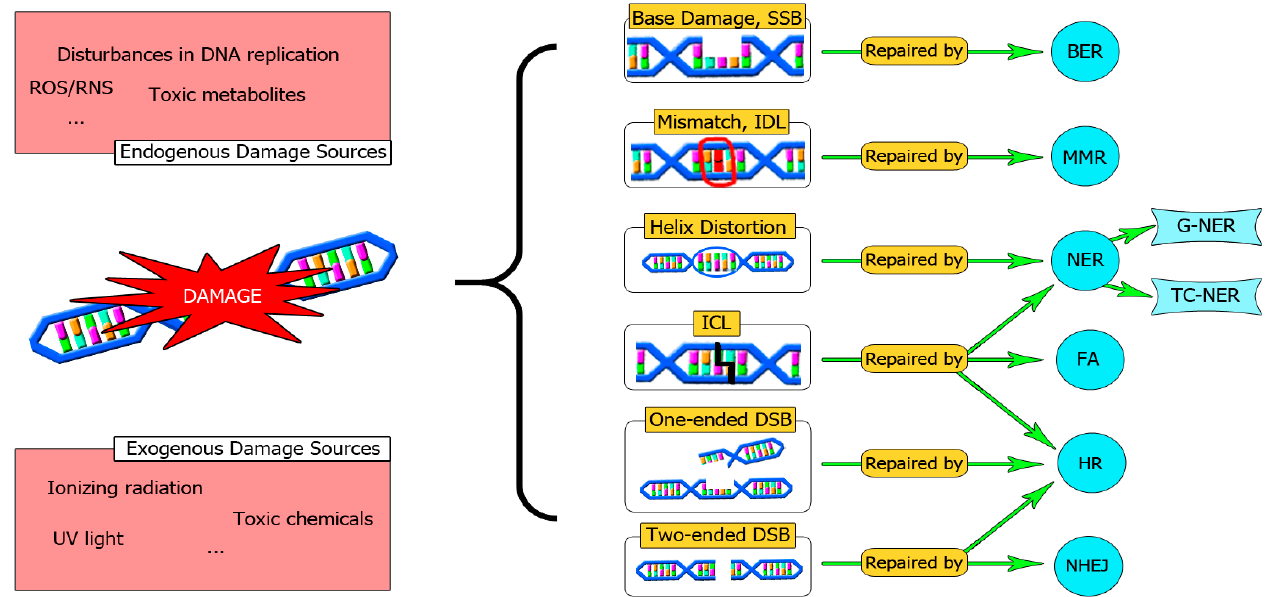
Figure 1. An overview of the main DNA repair systems. DNA can be damaged by exogenous or endogenous agents. A DNA repair defect can be a source of mutations that drive malignancy progression. Sometimes there is a cooperation between different repair pathways to solve complex DNA lesions, such as ICLs. In this sense, a fine-tune cooperation between HR and NER orchestrated by FA is required. SSBs: Single Strand Breaks, BER: Base Excision Repair, IDL: Insertion-Deletion Loops, MMR: Mismatch Repair System, NER: Nucleotide Excision Repair, TC-NER: Transcription coupled-NER, G-NER: Global-NER, DSBs: Double-Strand Breaks, NHEJ: Non-Homologous End Joining, HR: Homologous Recombination, ICL: Interstrand Cross Links, FA: Fanconi Anemia Pathway.